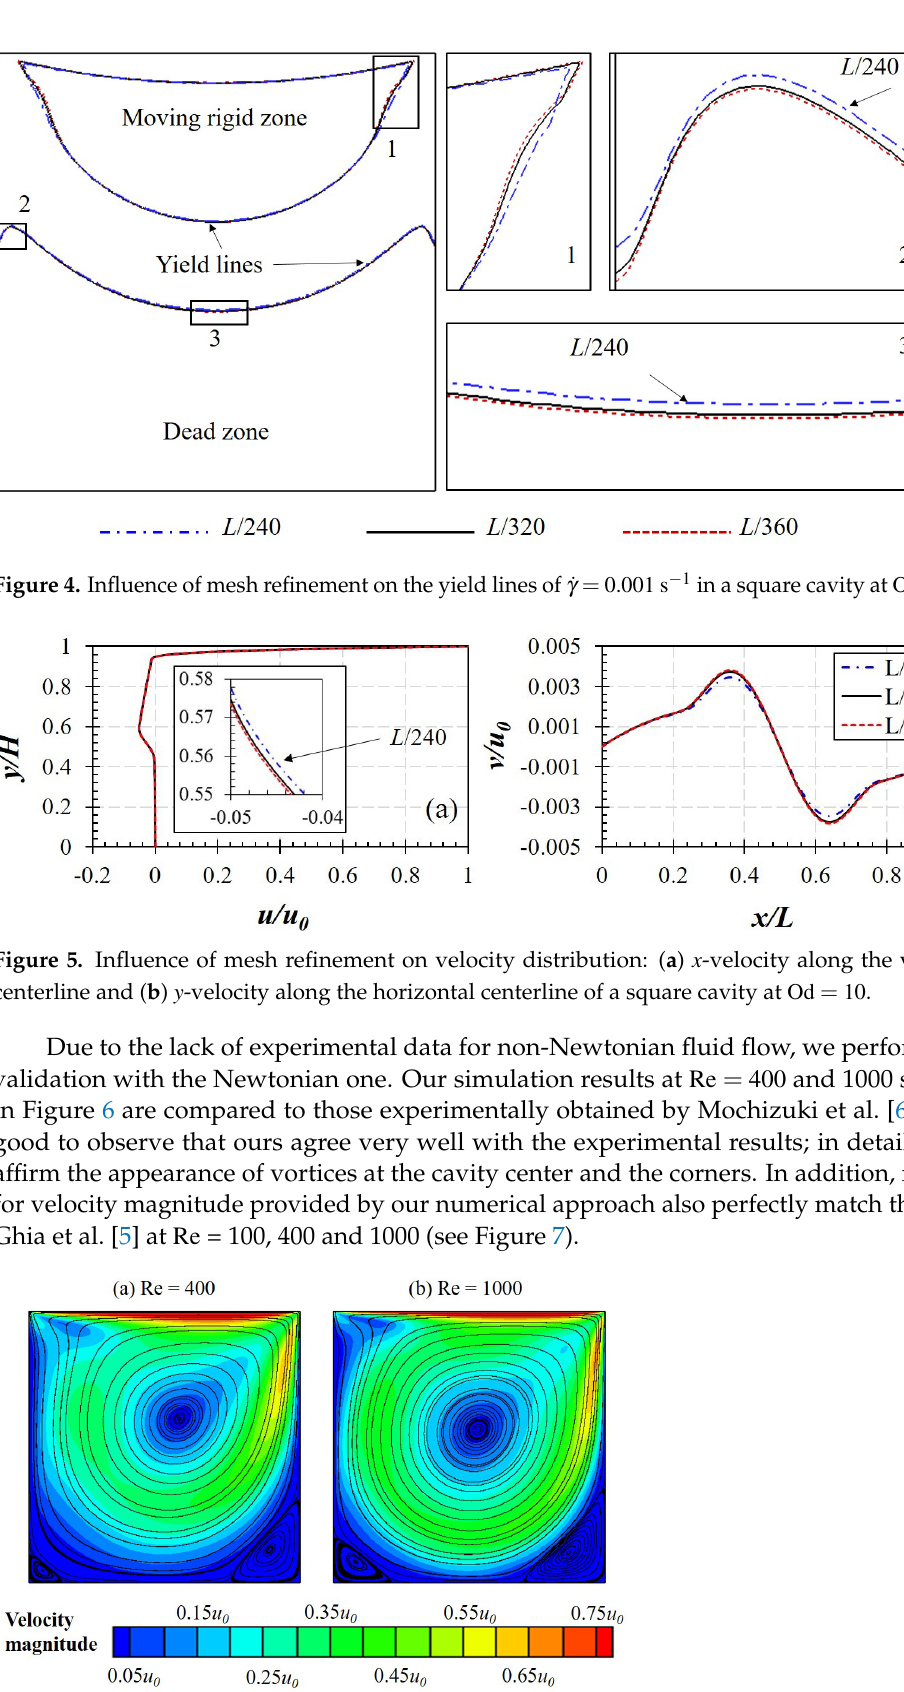
Figure 6. Flow streamlines of a Newtonian fluid in a square lid-driven cavity at ( a ) Re = 400 and ( b ) Re = 1000